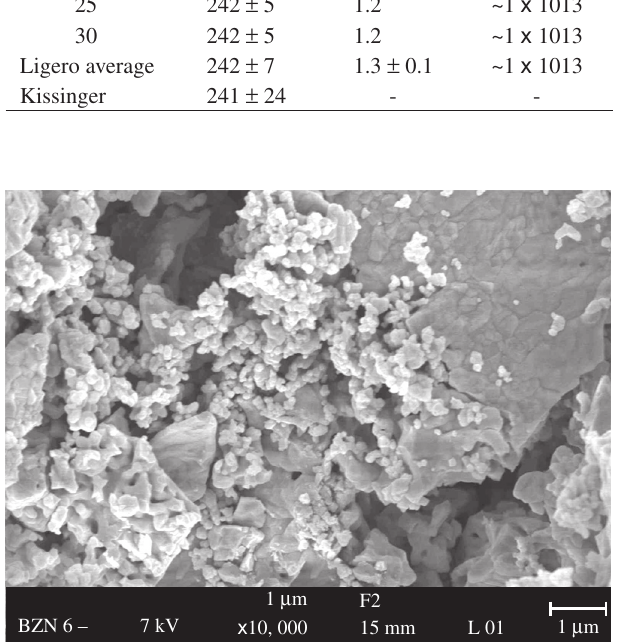
Figure 7. SEM image of α -BZN precursor treated at 700 °C for 2